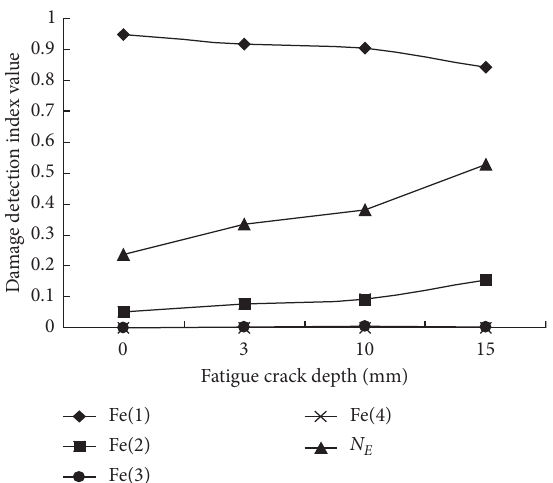
Figure 8: Change curve of damage detection index value under hammer excitation.